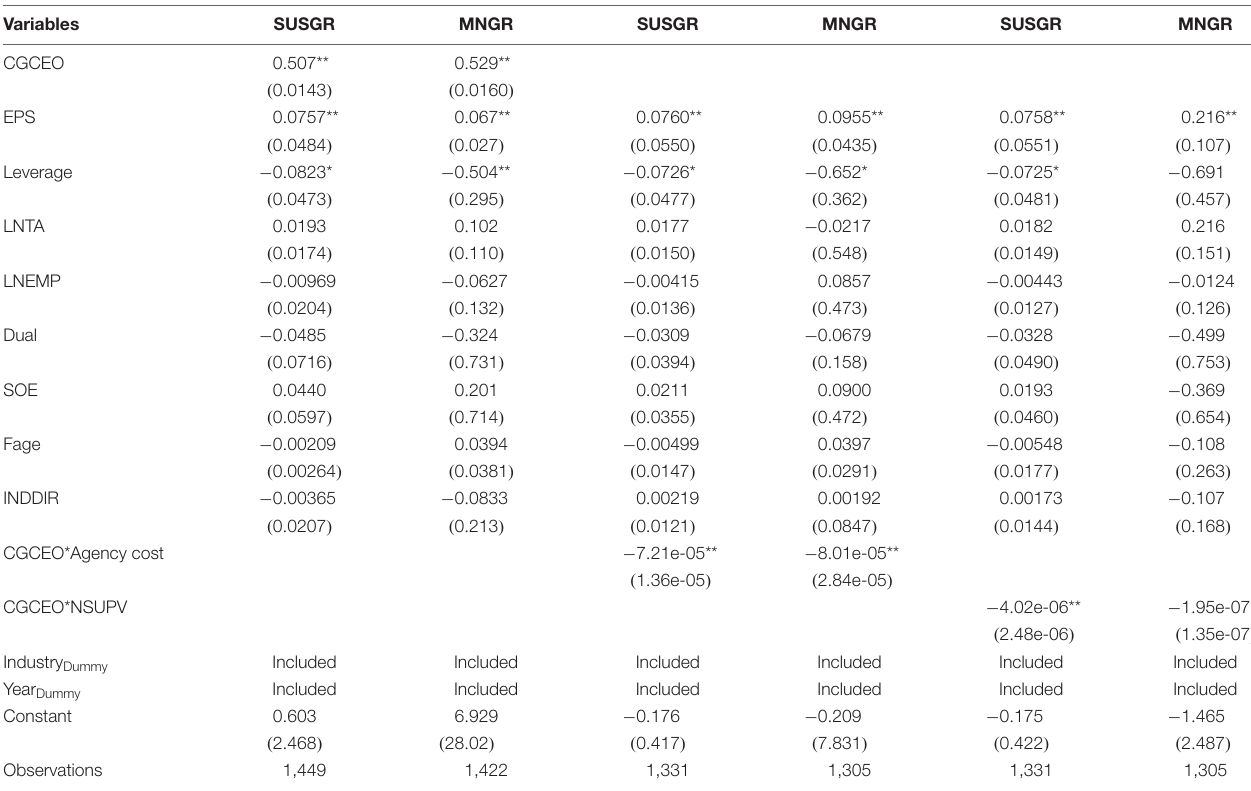
TABLE 6 | GMM instrumental regressions of cognitive CEO and moderators for sustainable growth. Variables SUSGR